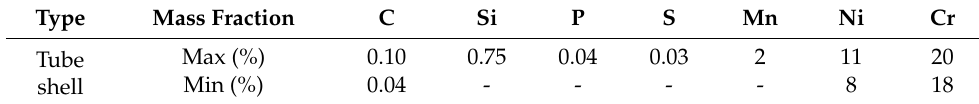
Table 2. Chemical composition of 304 stainless steel for tube shell with a 25 mm diameter [26].